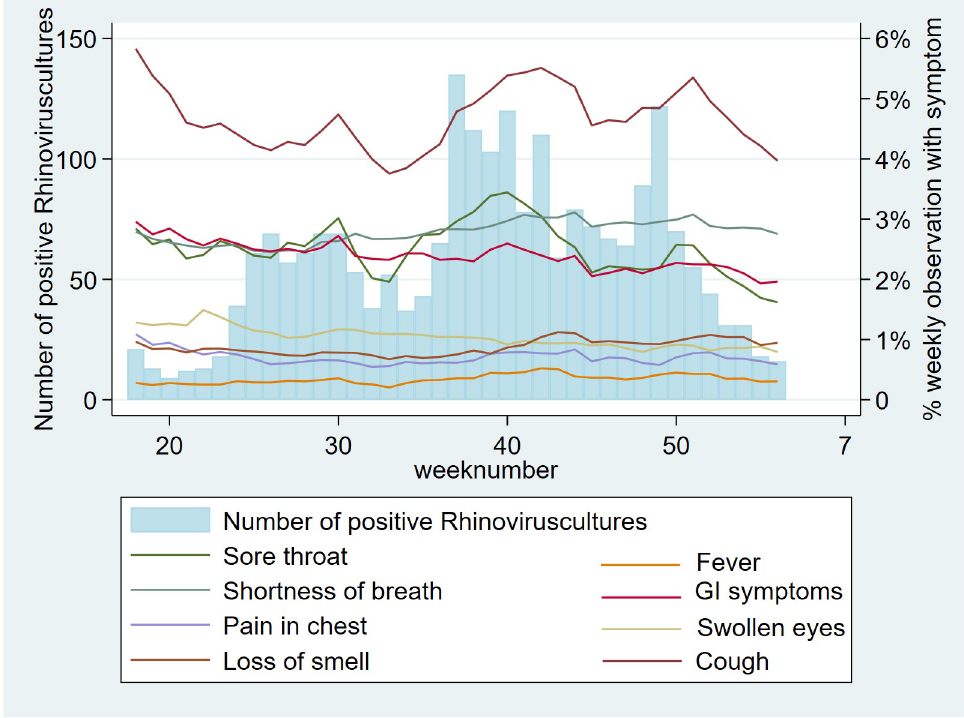
Fig 10. Symptoms vs. time (weekly) alongside number of nationally reported positive cultures of Rhinovirus (percentage of users reporting symptoms).